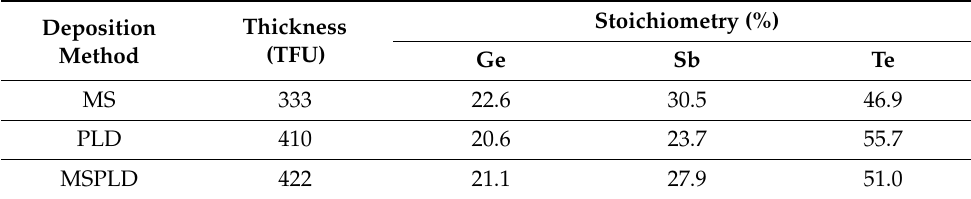
Table 1. Composition of the thin films obtained by RBS.